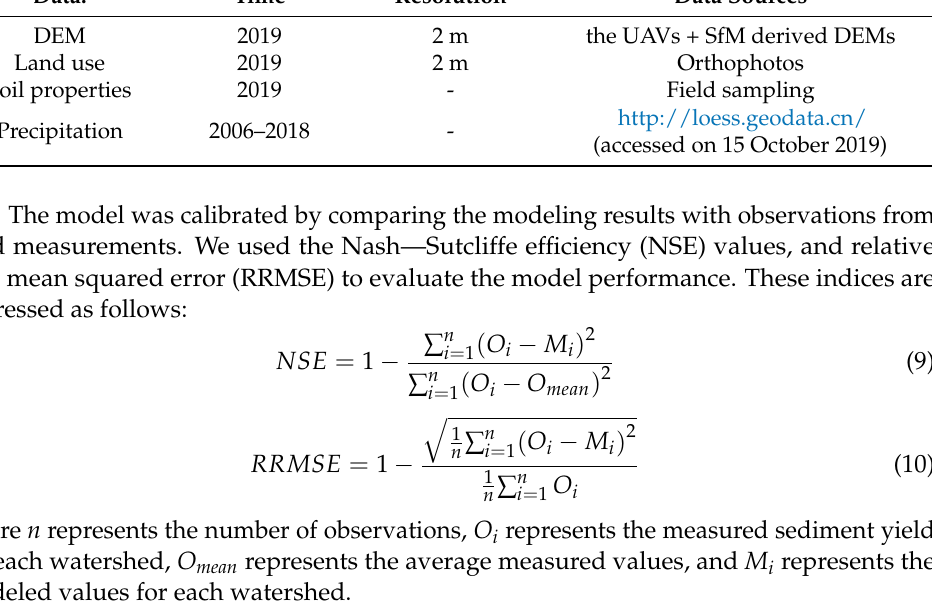
Table 3. Data used in the SEDD model. Data. Time Resolution Data Sources DEM 2019 2 m the UAVs + SfM derived